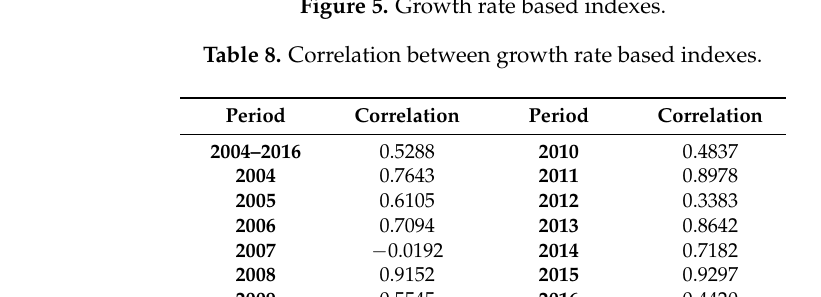
Table 8. Correlation between growth rate based indexes.